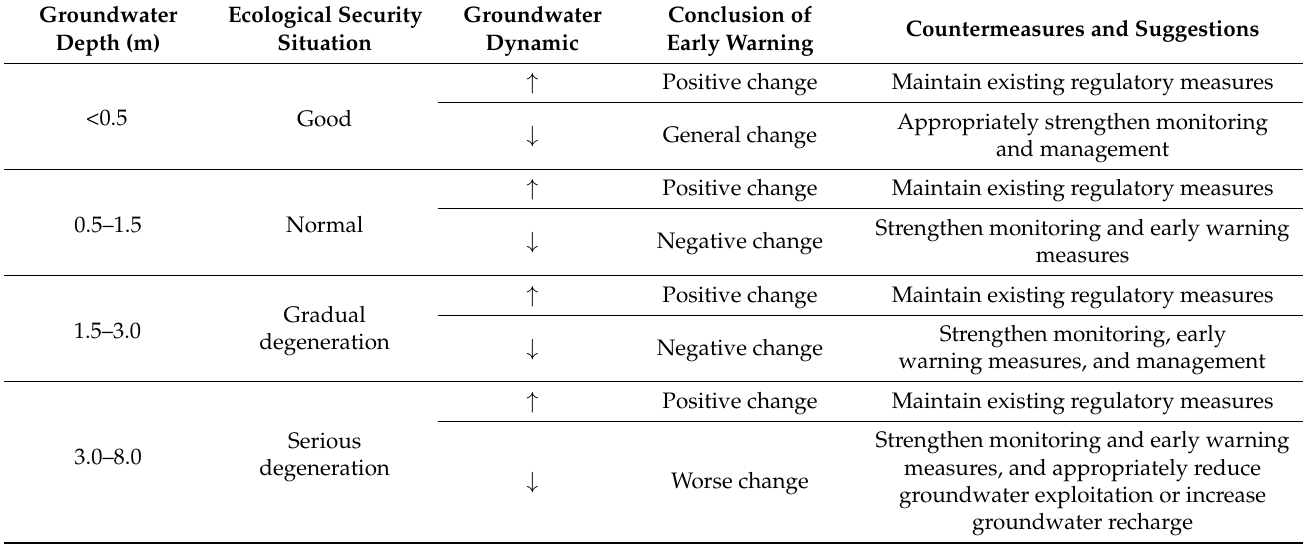
Table 2. Ecological security early warning and management threshold index system of natural wetland in northwest inland